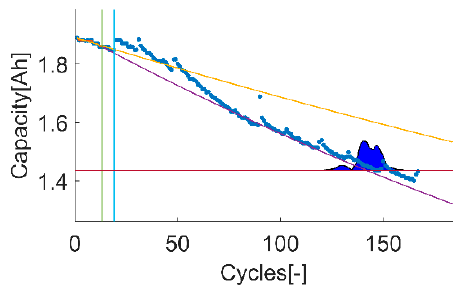
Figure 10. Time-instant figure of test 3 on t 4 .